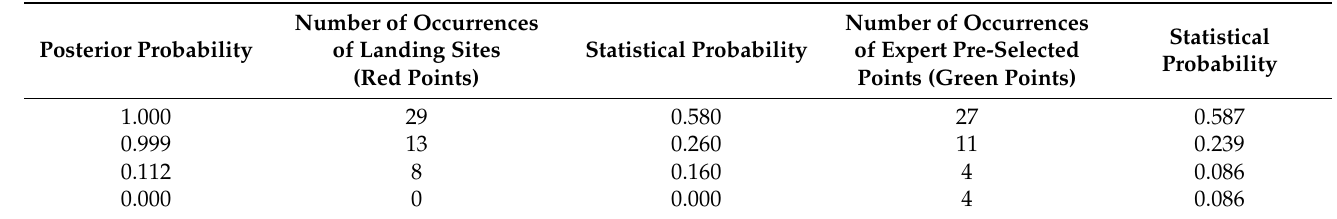
Table 2. The statistical results of the posterior probability statistics of the whole-moon landing zone selection based on weights of evidence and fractals. (288 selection based on weights of evidence and fractals. (288